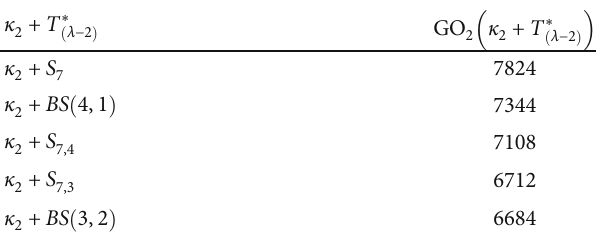
Figure 6: 1-apex tree. 2 -apex trees on 9 Table 3: GO 2 values of some